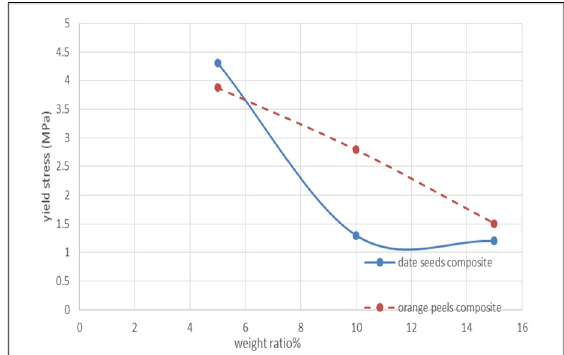
Fig. 8. Effect of weight ratio on fracture stress (natural material)